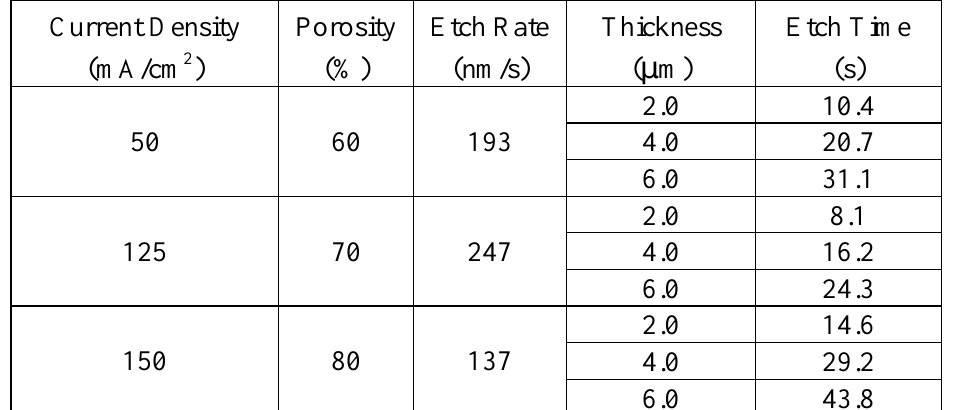
Table 1. PSi layers physical characteristics and fabrication